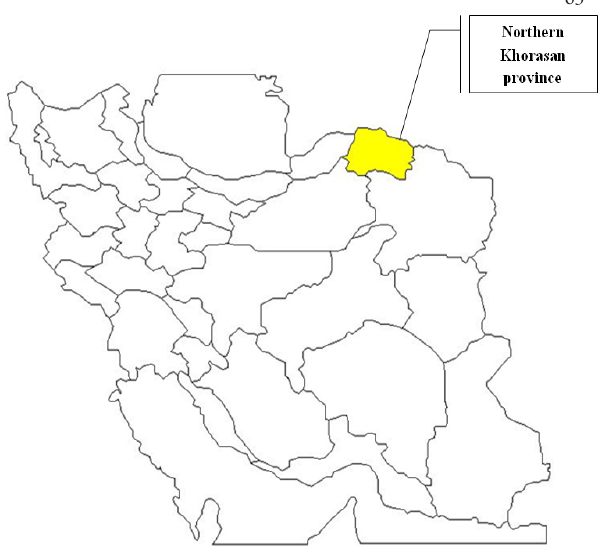
Fig. 1. Northern Khorasan province location in